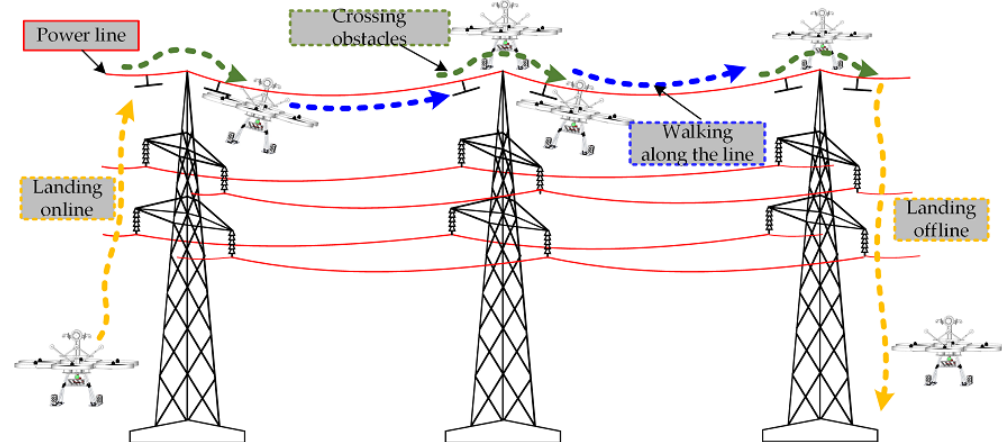
Figure 8. The whole inspection process of the FPLIR.